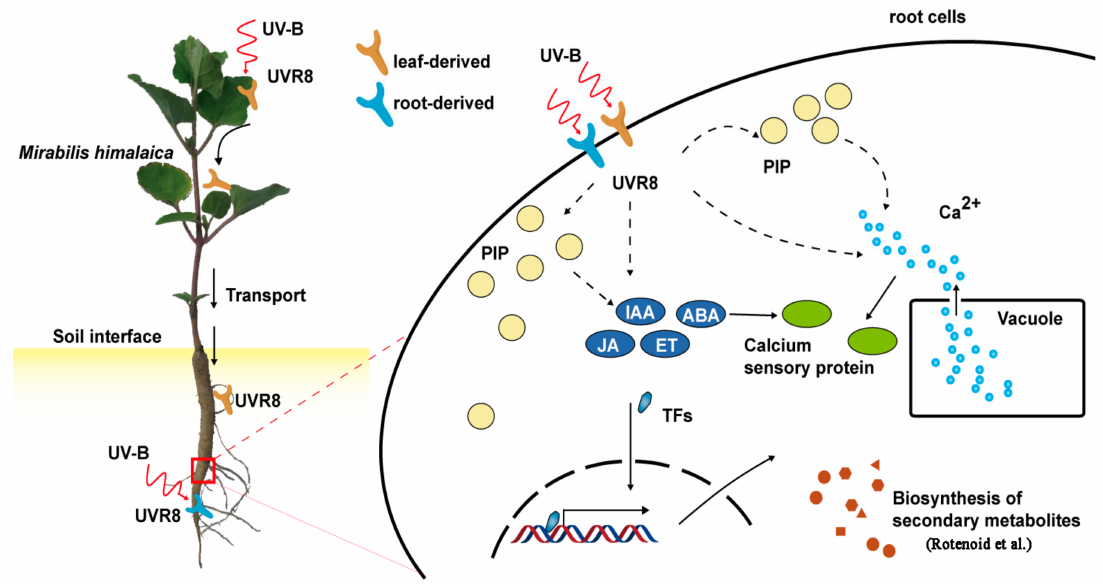
Figure 7. Key molecular pathways for M. himalaica response to UV-B